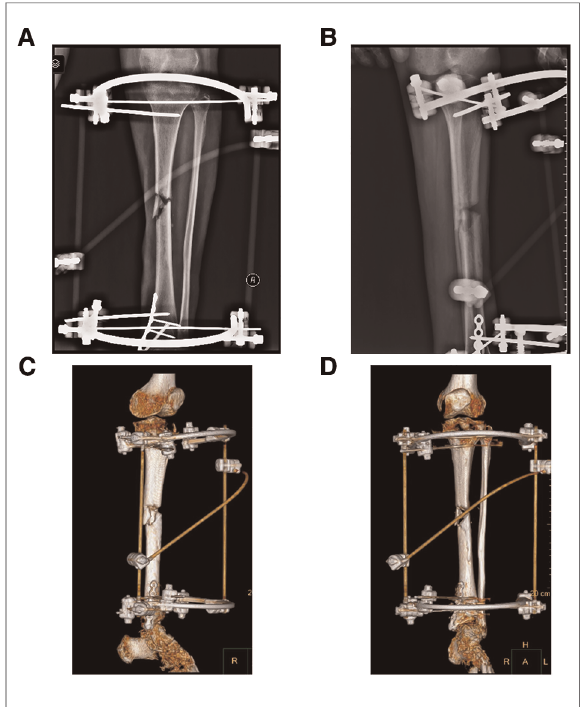
FIGURE 5 Preoperative x-ray and three-dimensional reconstruction of computed tomography (CT) of the left lower limb in case 2. ( A ) Preoperative x-ray on anterior-posterior (AP) view of case 2, and there is bone nonunion in the middle of tibia. ( B ) Preoperative x-ray on lateral view of case 2. ( C , D ) Three-dimensional reconstruction image of case 1 before